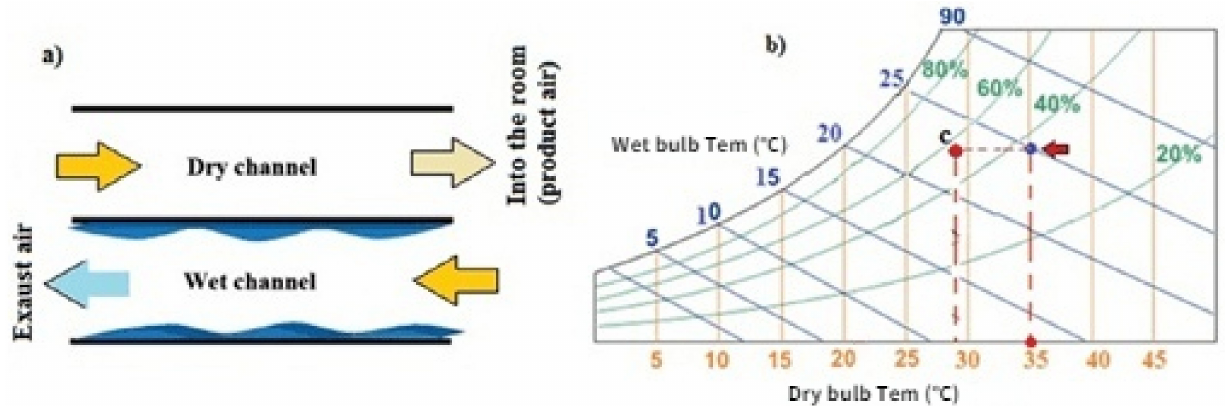
Figure 2. ( a ) Working diagram of indirect evaporative cooling (IEC); ( b ) Cooling process of IEC in psychrometric chart